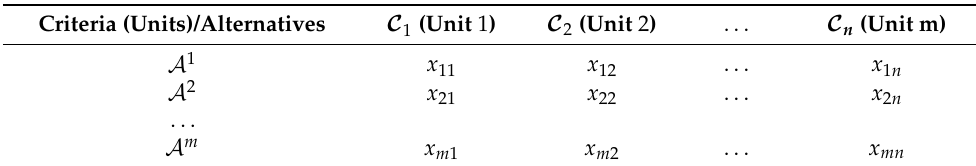
Table 1. Decision table of MCDA. Criteria